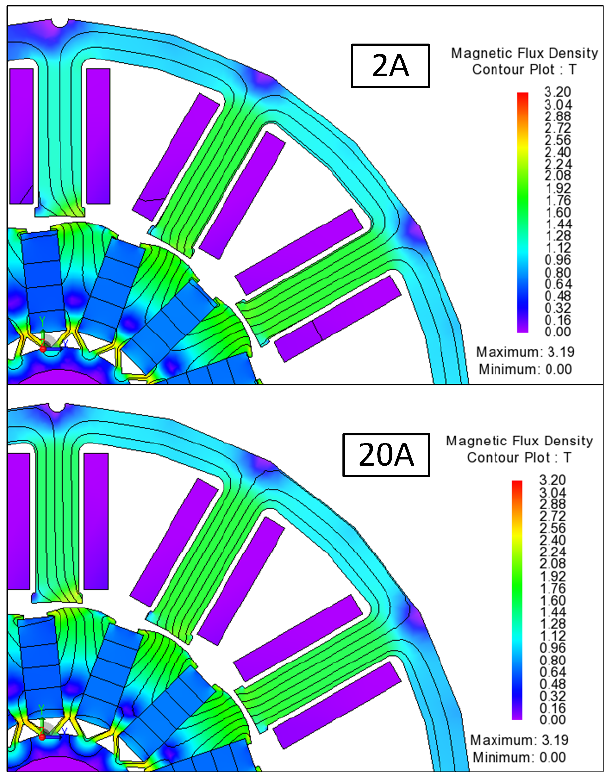
Figure 6. Flux density plots from FEA software with different excitation currents and at the same rotor position.